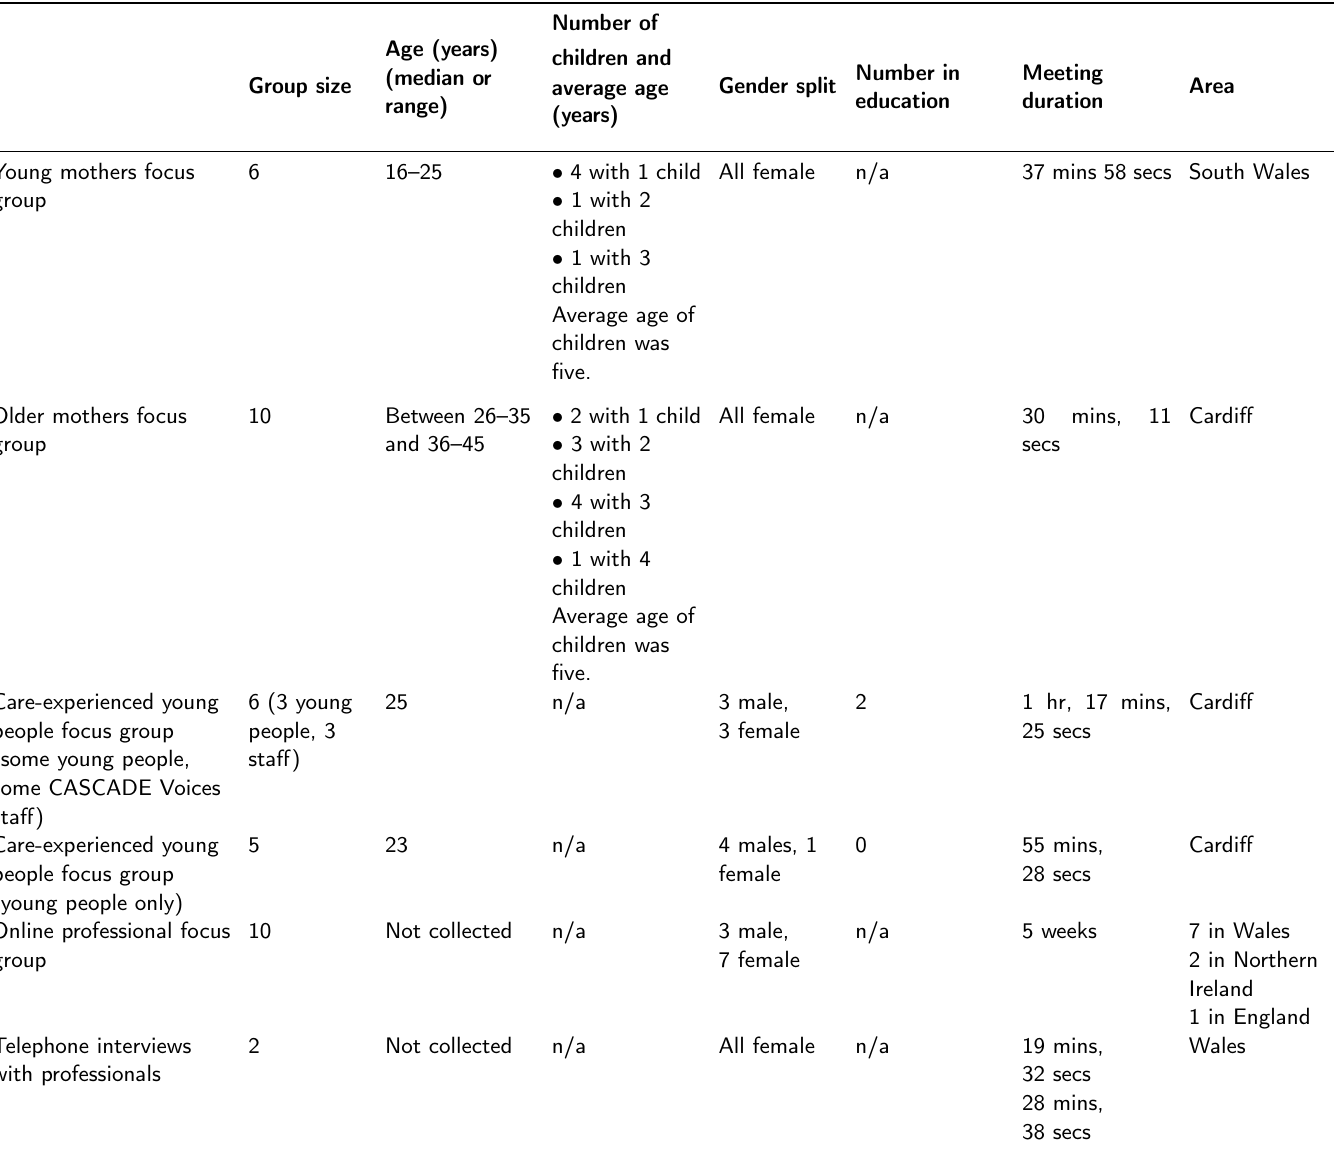
Table 1: Focus groups and interviews composition